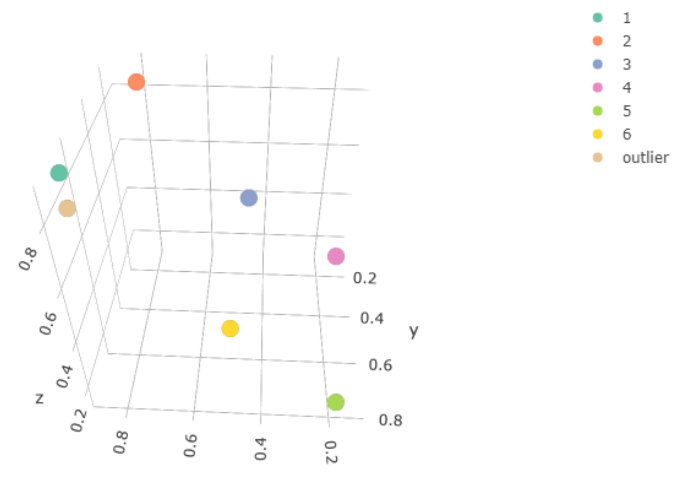
Figure 2. Mean vector of each component, in x, y, z coordinates.